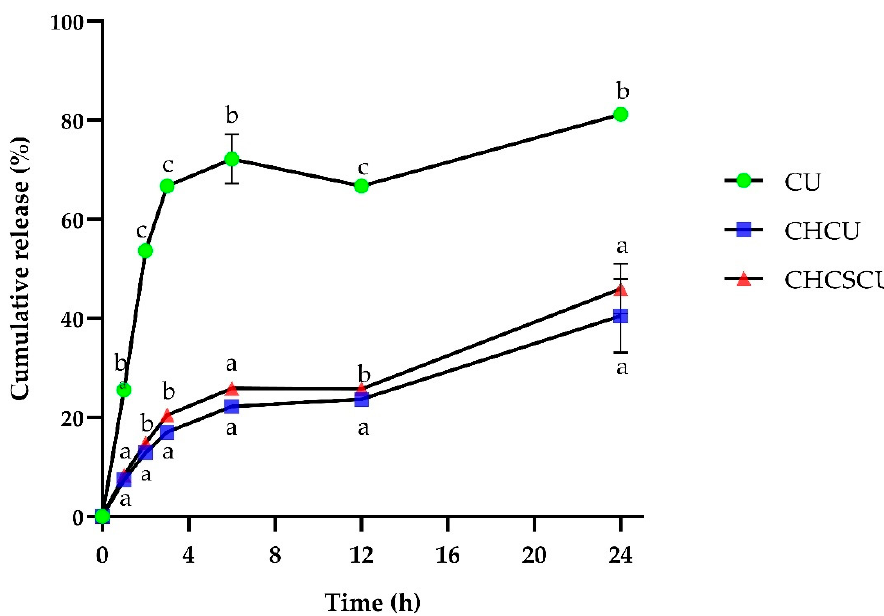
Figure 7. In vitro release profiles of curcumin (CU), CU-loaded nanoparticles with chitooligosaccha- rides (CH), and chondroitin sulfate (CS) in phosphate-buffered saline, pH 6.8. Notes: Mean ± SD, n = 3. Table 2. Model parameters for curcumin (CU), and CU-loaded nanoparticles with chitooligosaccha- rides (CH), and chondroitin sulfate (CS) after fitting the in vitro drug release data to four different mathematical